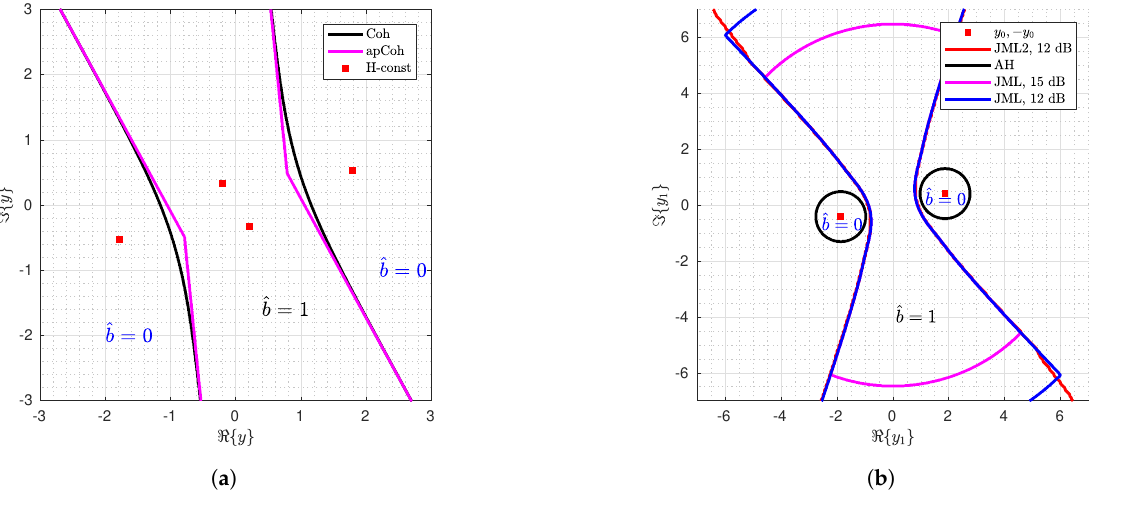
Figure 5. Decision regions of the coherent ( a ) and differential detectors ( b ). ( a ) Decision regions for coherent and approximate coherent detector. For SNR = 0 dB. η = 0.9, ϕ 1 = 0.1 rad, ϕ 2 = 0.5 rad. ( b ) Decision regions for the differential ad hoc detector, JML detector (for two SNRs) and JML2 detector. Decision regions on y 1 for given y 0 . For η =